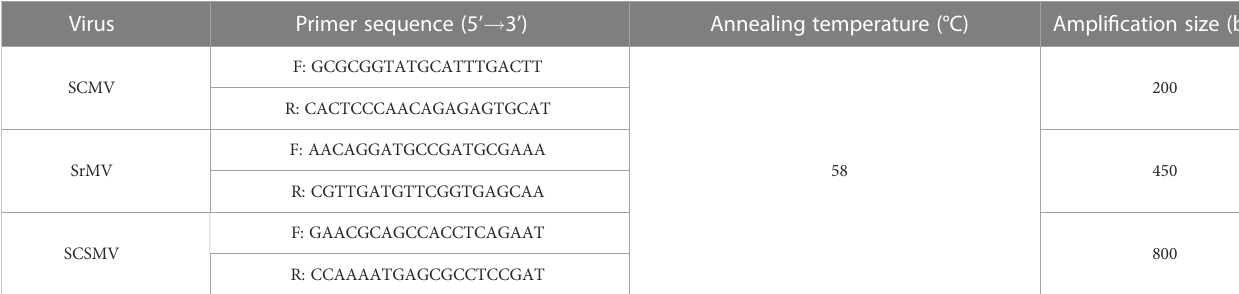
TABLE 1 Species-speci fi c RT-PCR primers for the detection of three sugarcane mosaic viruses. Virus Primer sequence (5 ’ ! 3 ’